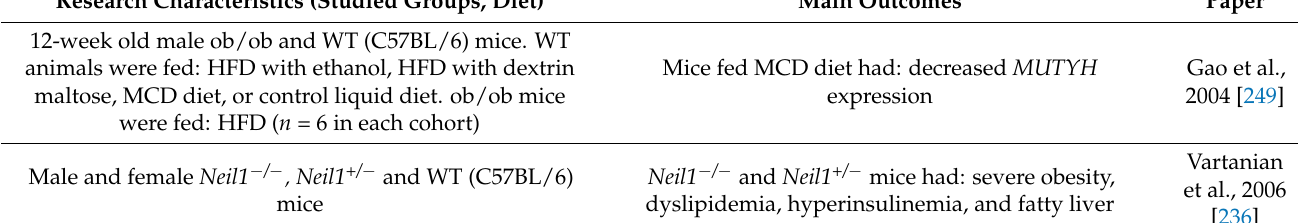
Table 1. The studies demonstrating the role of DNA repair in the course of lipid and insulin metabolism as well as fatty liver. Research Characteristics (Studied Groups, Diet) Main Outcomes